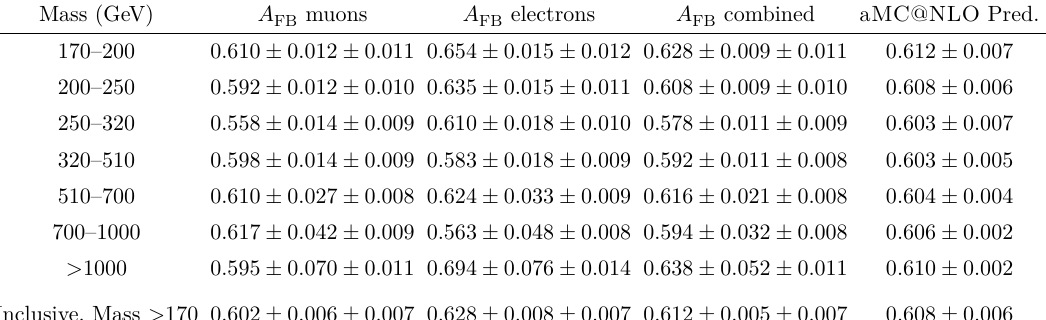
from the maximum likelihood fit to data in different Table 2 . Results for the measurement of A FB dilepton mass bins in the different channels as well as an inclusive measurement across all mass bins. The first and second uncertainties listed with each measurement are statistical and system- atic, respectively. The last column lists the predictions of A and associated uncertainties from FB a MC@NLO